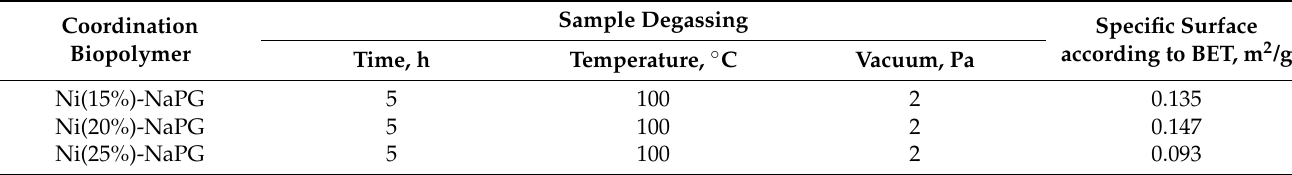
Table 6. Specific surface area of the coordination biopolymers, measured on the QuantachromeNova 1200e by the adsorption of nitrogen gas using the Brunauer, Emmett and Teller method (BET—